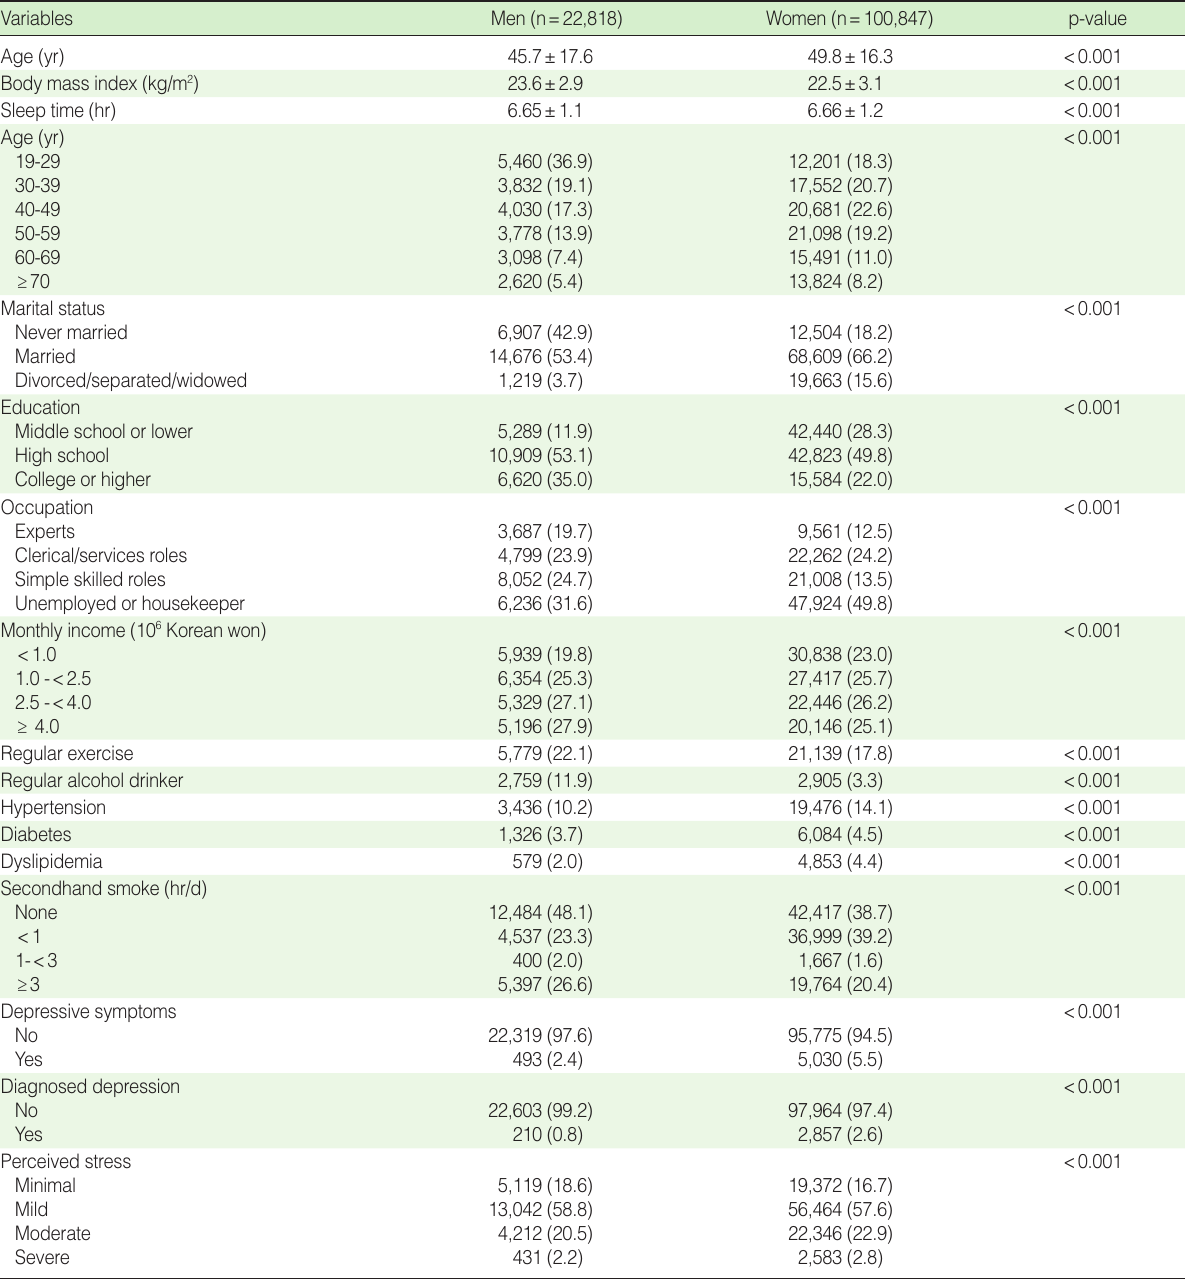
Table 1. Basic characteristics by gender (n=123,665)